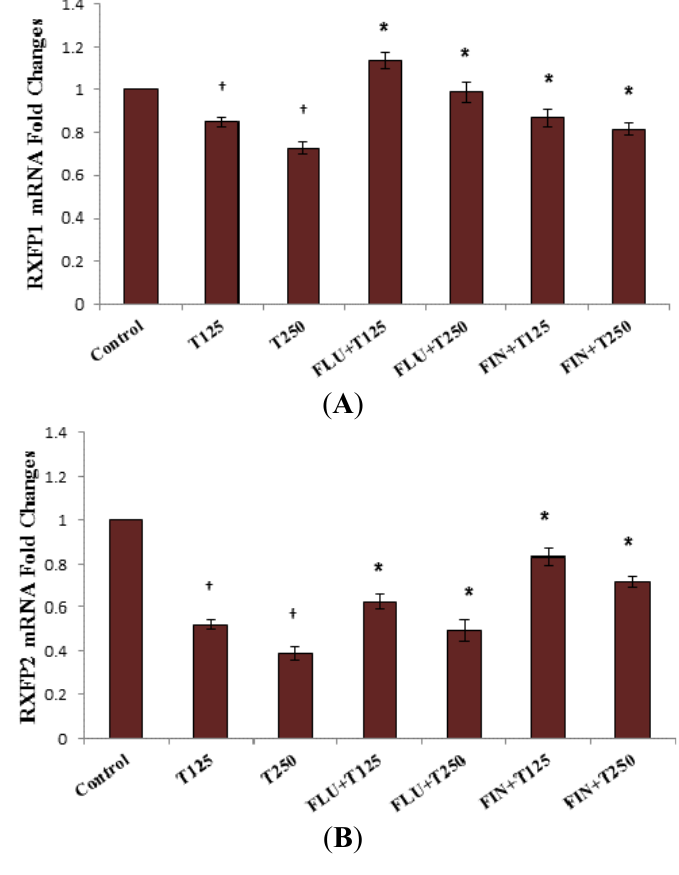
Figure 4. Changes in Rxfp1 ( A ) and Rxfp2 ( B ) mRNA expression in the lateral collateral ligament of steroid-replaced ovariectomised rats in the presence of FLU and FIN. Treatment with 125 and 250 μ g/kg/day testosterone caused a decrease in Rxfp1 and Rxfp2 mRNA expression as compared to control (testosterone only treatment) ( p <